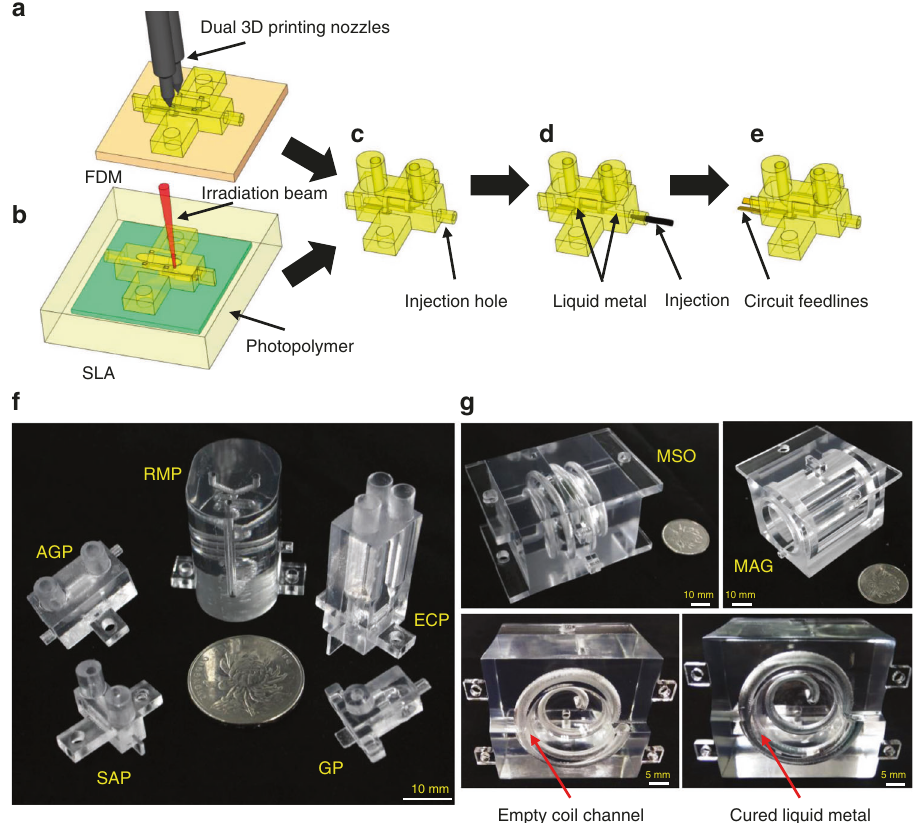
Fig. 1 3D printing and manufacturing procedure of integrative MR probeheads for different scenarios. Both a fused deposition modeling (FDM) and b stereo lithography appearance (SLA) techniques are utilized to fabricate a complete probehead ( c ) layer by layer according to the simulation design. d Liquid metal is perfused into the model through the injection hole to form an RF coil. e The RF coil is connected to the matching circuit by two copper strips to form a complete probe. The entrance and exit of the liquid metal channel are completely sealed with silver paste. Various 3D-printed probeheads suitable for MR applications can be fabricated and utilized, including f U-tube saddle probehead (SAP), U-tube Alderman-Grant probehead (AGP), reaction monitoring probehead (RMP), electrochemical reaction monitoring probehead (ECP), gradient probehead (GP) for MR, and g modi fi ed solenoid imaging probehead (MSO), modi fi ed Alderman-Grant imaging probehead (MAG) for MRI. The coil channel of MSO probehead, before and after the liquid metal perfusion, are also shown. Table 1 Dielectric constant and loss tangent of 3D-printed building materials. VisiJet M3 Crystal Clara A